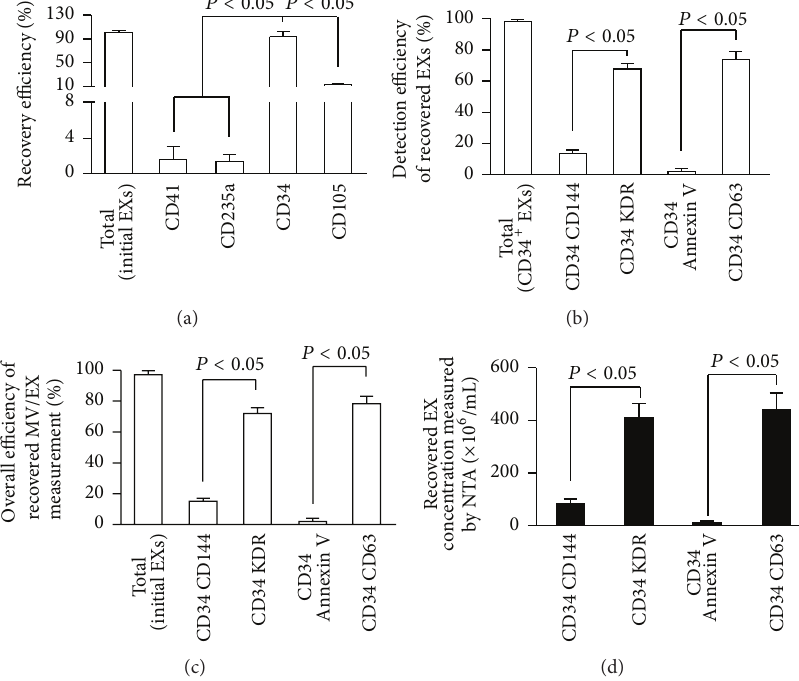
Figure 5: High recovery and detection efficiency of EPC-EXs from particle-free plasma by using microbead purification and fluorescence NTA detection methods. (a) EPC-EXs were recovered from particle-free plasma by using microbeads conjugated with various antibodies and analyzed by NTA. (b) The detection efficiency of recovered CD34 + EXs that were labeled with secondary antibodies (CD144, or KDR, or Annexin V, or CD63) conjugated with Q-dots and analyzed by fluorescent NTA. (c) The overall efficiency for measuring the recovered CD34 + EXs colabeled with CD144-, or KDR-, or Annexin V-, or CD63-conjugated Q-dots. (d) The absolute number of recovered CD34 + EXs